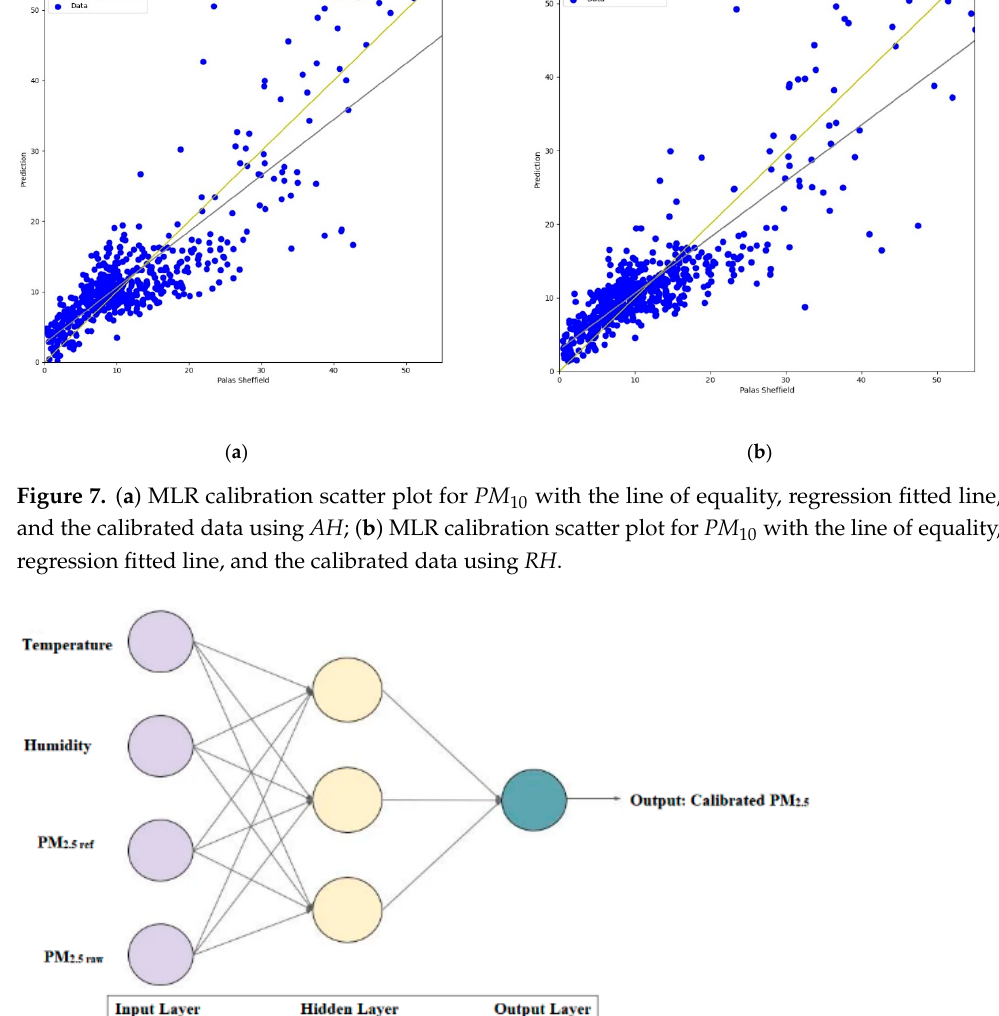
Figure 8. Block diagram of the Multi-Layer Perceptron model.